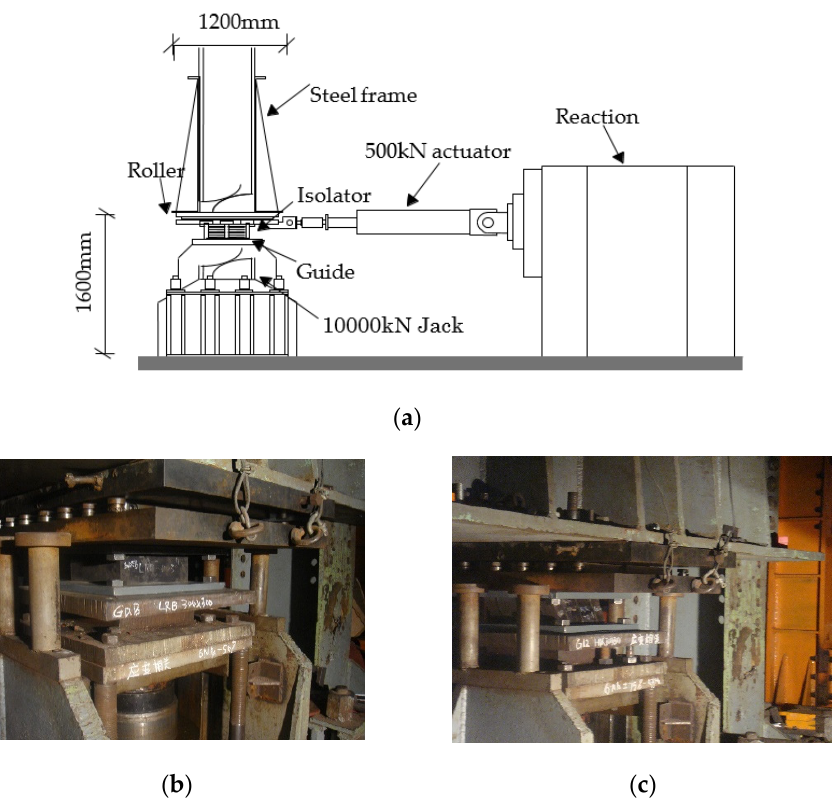
Figure 3. Test equipment and isolator used for testing. ( a ) Top-down view of test equipment; ( b ) LRB in testing; ( c ) SHDR in testing.